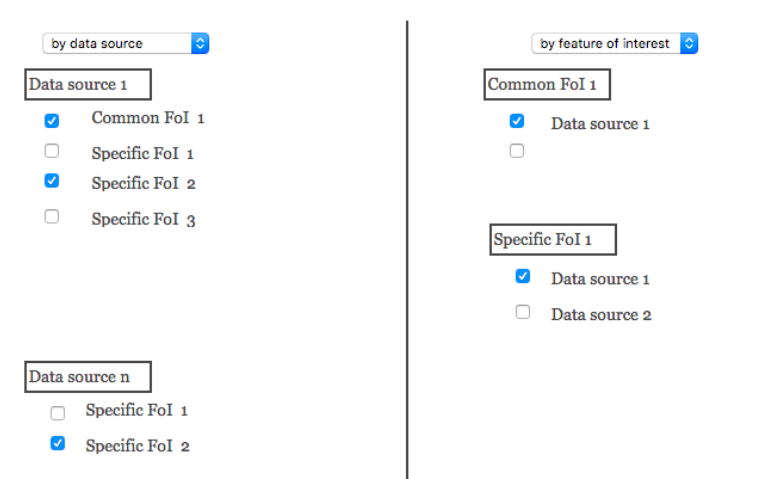
Figure 15. Points of view in the